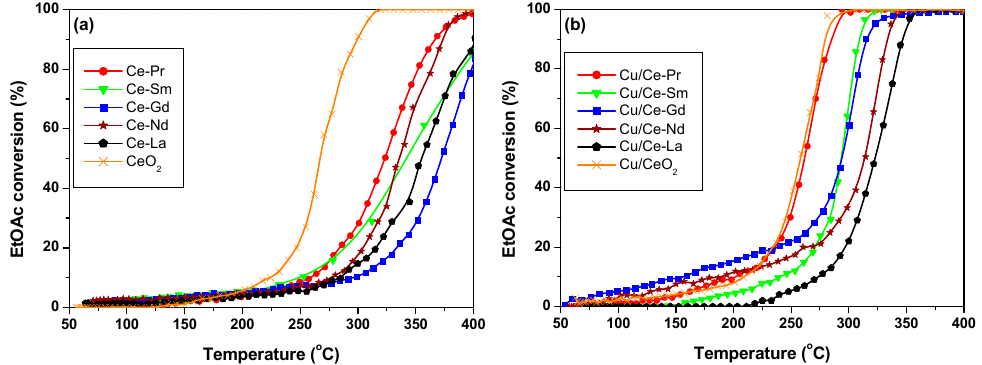
Figure 8. EtOAc conversion over Ce-Ln ( a ); and Cu/Ce-Ln ( b ) samples (Ln: Gd, La, Pr, Nd, Sm). Reaction conditions: [VOC] in = 1000 mg Carbon /m 3 , GHSV = 60,000 h − 1 . The error for catalytic experiments is ±2 °C.